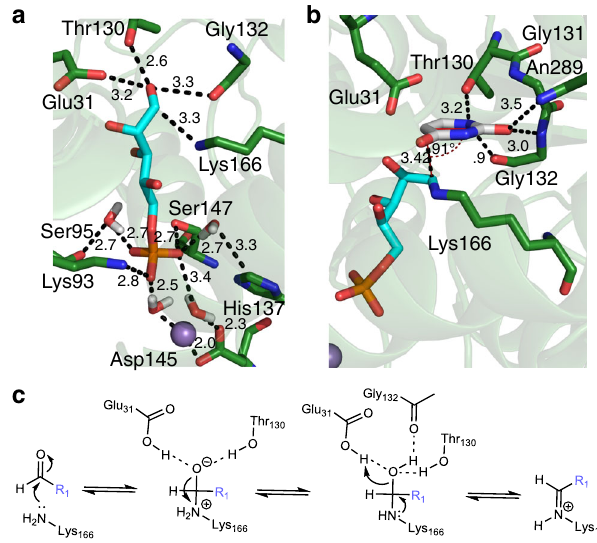
Fig. 3 The substrate speci fi city of YeiN analyzed with molecular docking. Docking poses of a D -Rib5P ( 1 , cyan) and b Ura ( 12 , white). The enzyme bound Mn 2 + is shown as a violet sphere. Distances are shown in